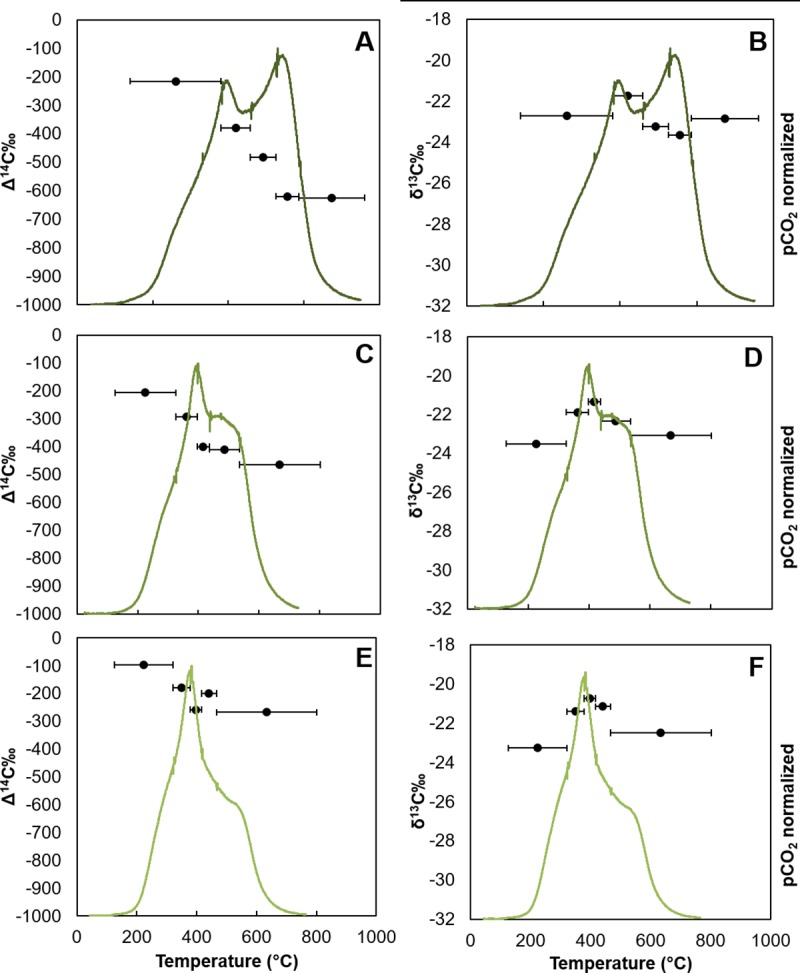
CO2 thermograph and isotopic composition of evolved
CO2 for high PAH site BP444.Temperature interval of CO2 fractions indicated by horizontal
bars. A) 0-1cm Δ14C, B) 0-1cm δ13C, C) 1-2cm
Δ14C, D) 1-2cm δ13C, E) 3-4cm Δ14C,
and F) 3-4cm δ13C.